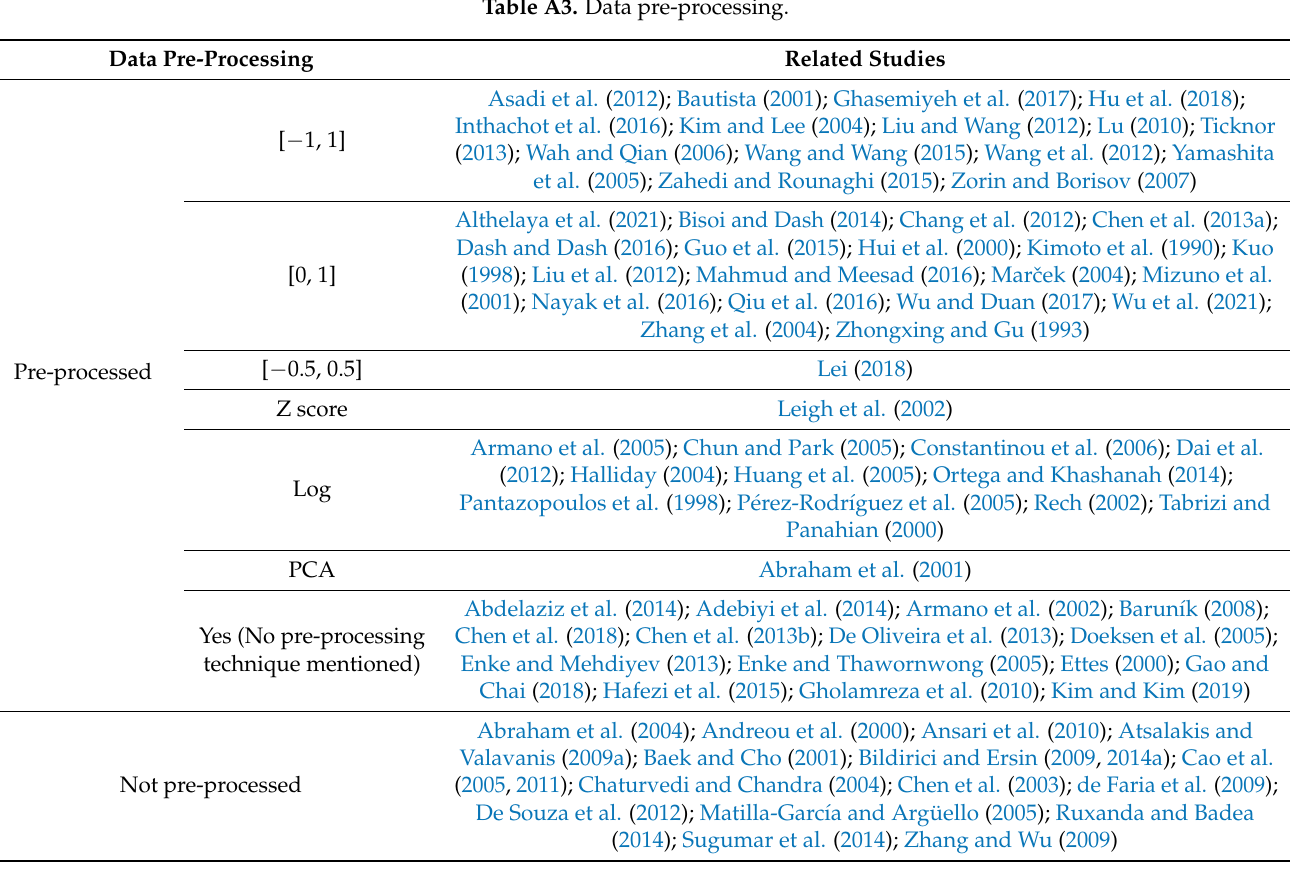
Table A3. Data pre-processing.